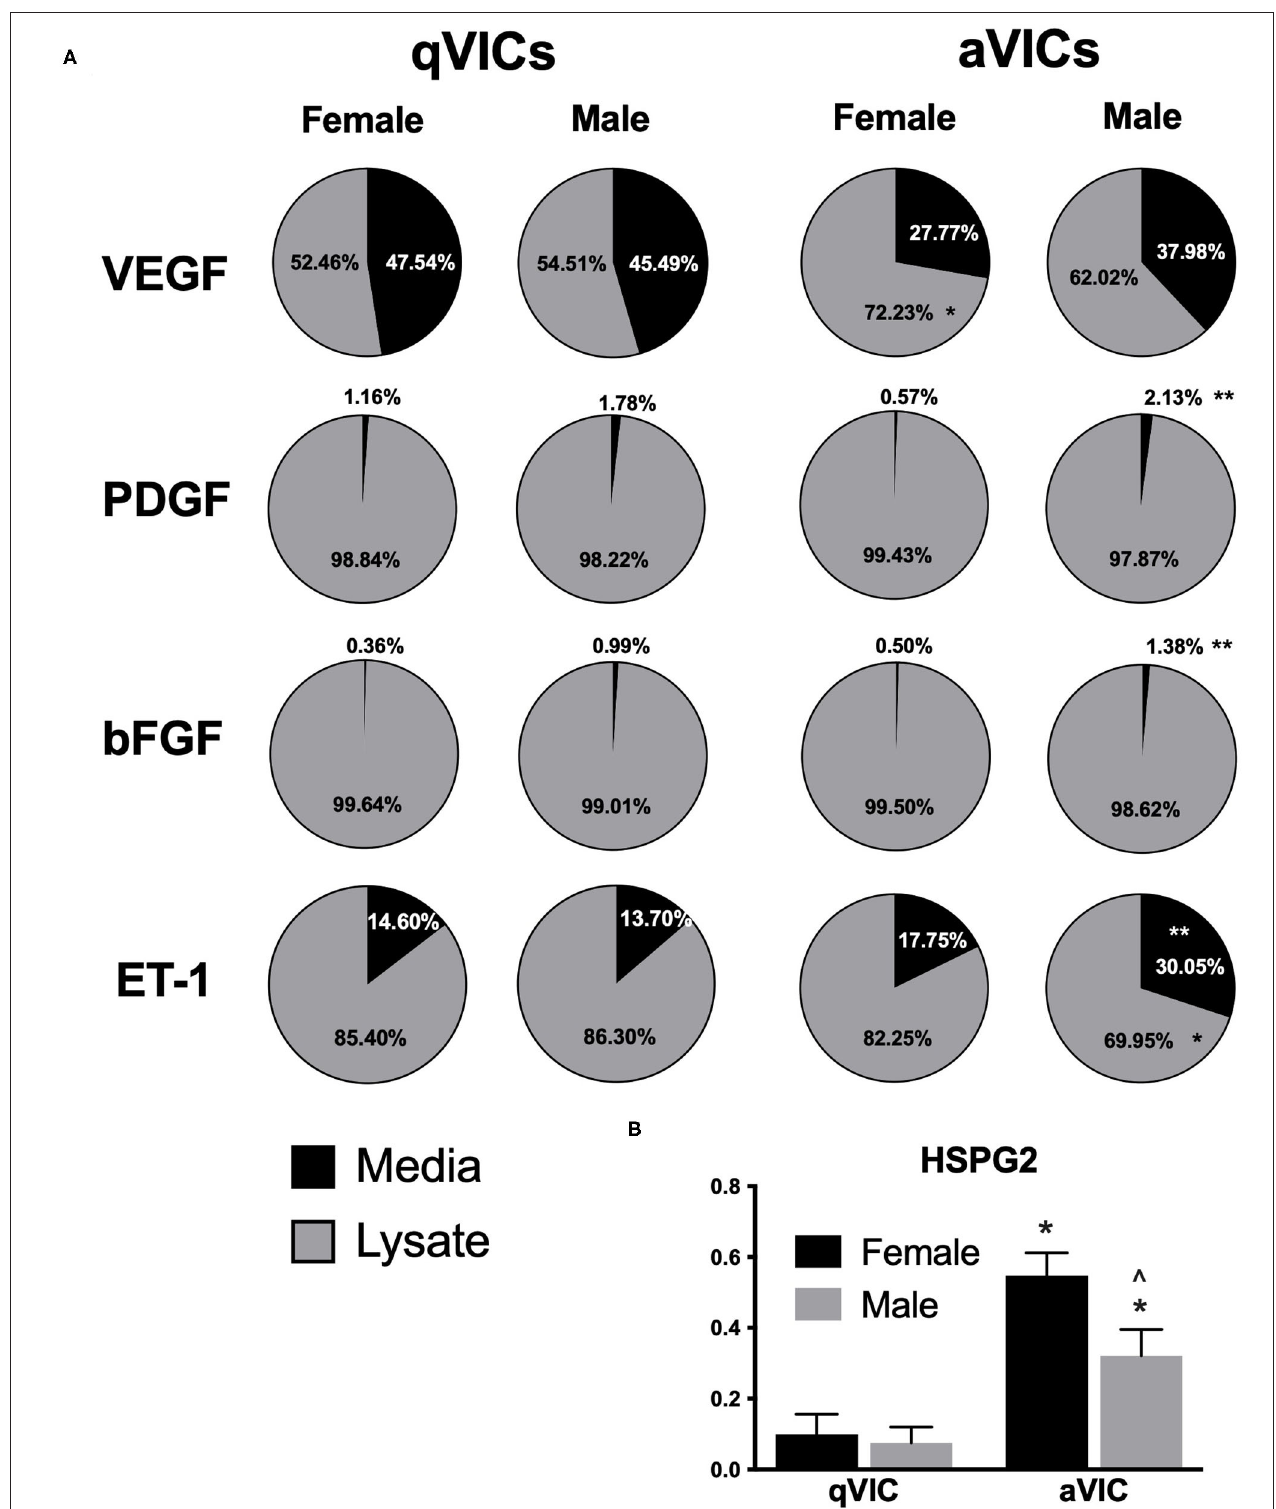
FIGURE 2 | Distribution of pro-angiogenic factors across media and lysate from male and female qVICs and aVICs. (A) Percent of total growth factor found in media vs. lysate for VEGF, PDGF, bFGF, and ET-1. * p < 0.05 vs. sex-matched qVIC level; ** p < 0.05 vs. female VIC of same phenotype. (B) Heparan sulfate proteoglycan 2 (HSPG2) found in extracellular matrix of male and female qVIC and aVIC cultures. * p < 0.05 vs. sex-matched qVIC level; ∧ p < 0.05 vs. female VIC of same phenotype by two-way ANOVA with Tukey’s post hoc test. N = 3 pigs per sex, n = 3 wells per condition.